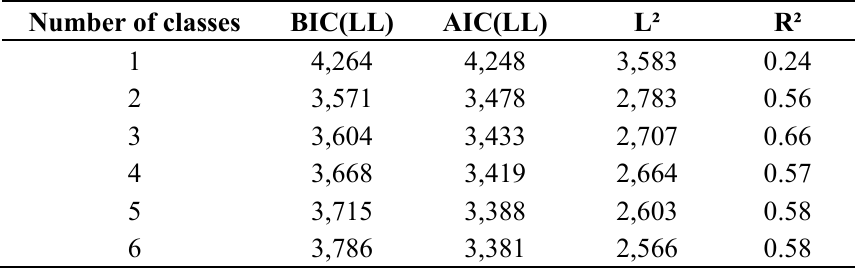
Table 3. Bayesian (BIC) and Akaike (AIC) information criteria for selecting the number of